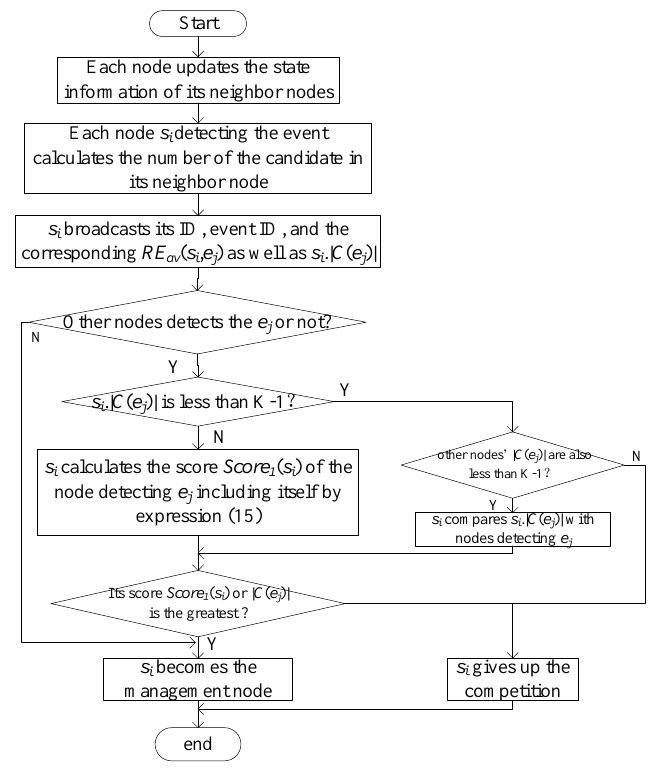
Figure 3. Flowchart of Section 3.2.1.